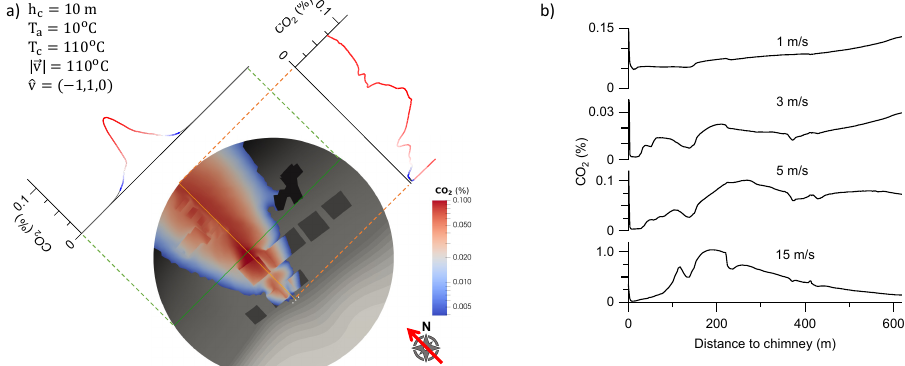
Figure 9. CO 2 concentration sections at ground level. Panel ( a ) shows the line distribution of CO 2 parallel to the main wind flow of 5 m/s (orange line) below the center of the plume where the concentration is the highest. A line distribution crossing the plume perpendicular to the wind flow along the highest concentration (green line) is also shown. The concentration distribution around the center is approximately gaussian. Panel ( b ) shows the CO 2 distribution downwind for 1, 3, 5 and 15 m/s wind speeds. The wind blows in the north-west ( − 1,1,0 ) direction. The chimney is 10 m high and the gas has 110 ◦ C at the exit of the plume. The ambient temperature is 10 ◦